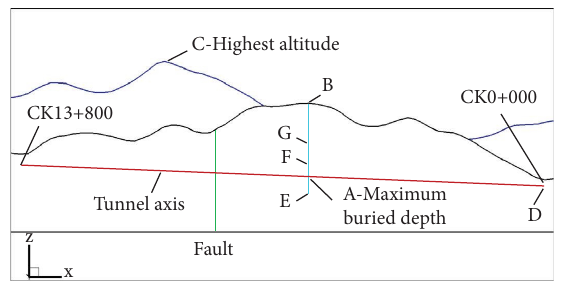
Figure 5: Tunnel profle and observation